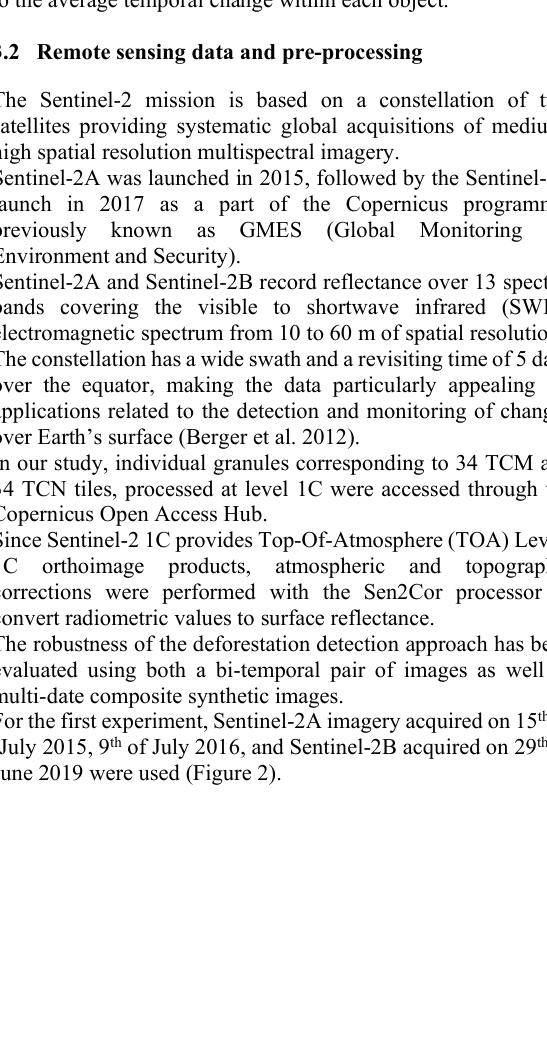
Figure 3. T34 TCM and TCN median composites over the three selected sites for 2015 (a), 2016 (b), 2017 (c) and 2018 (d) In the composite approach, a new synthetic-image per annual period is created using the median values of all Sentinel-2 images having a cloud-cover less than 25%. While the median-composite-approach strongly depends on the available number of cloud-free images over the area of interest, it has been shown to provide robust, consistent results over different studies and remote sensing data (Griffiths et al.,